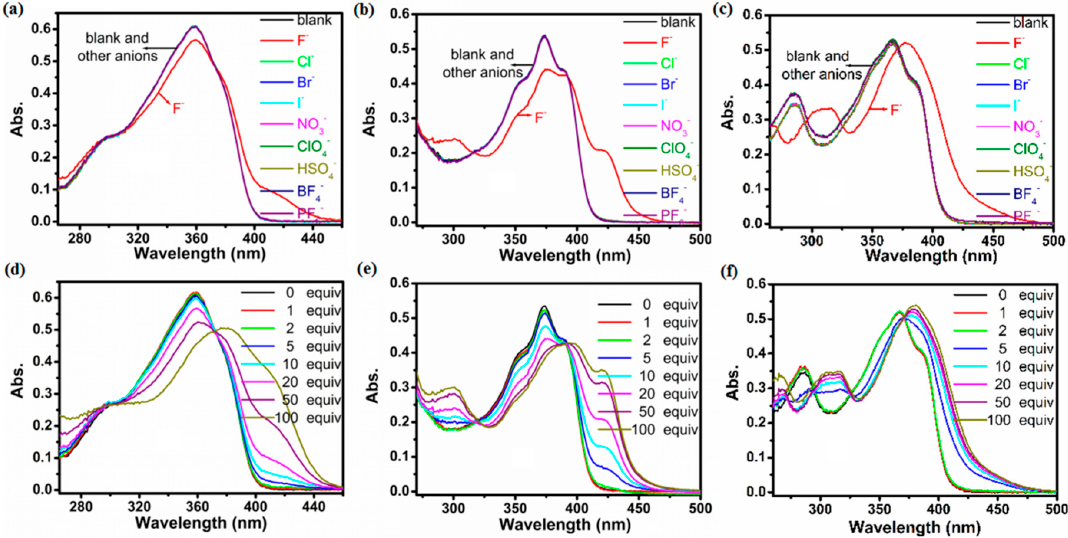
Figure 2. UV/Vis absorption spectra of DMSO solutions of ( a ) compound 1a ; ( b ) compound 1b ; and ( c ) compound 1c (10 − 5 mol L − 1 ) in the absence (blank) and presence of nine anions (20 equiv.). UV/Vis absorption spectra of DMSO solutions of ( d ) compound 1a ; ( e ) compound 1b ; and ( f ) compound 1c (10 − 5 mol L − 1 ) with different amounts of Bu 4 N + F − .